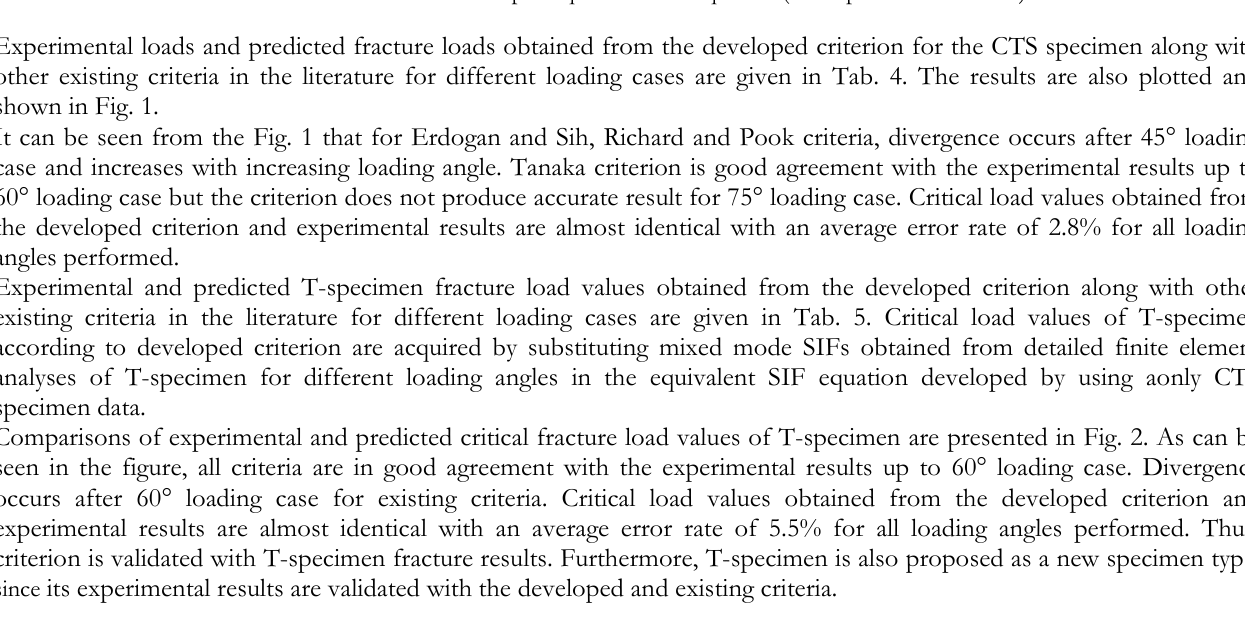
Table 3: Coefficients of developed equivalent SIF equation (CTS specimen data